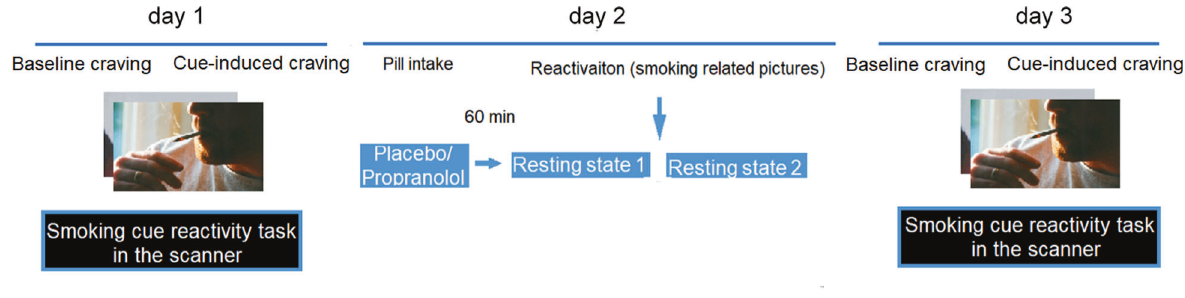
Fig. 1 Experimental design and protocol. Recruited smokers came to the lab, completed the craving evaluation, and performed a cue- reactivity task in the fMRI scanner. Twenty-four hours later, they took a placebo or propranolol (40 mg) pill 1 h before they underwent two resting-state fMRI scans. Before the second scan, the participants reactivated the nicotine-associated memories by being exposed to smoking- related pictures. Again 24 h later, all of the participants completed the craving evaluation and the same cue-reactivity task in the